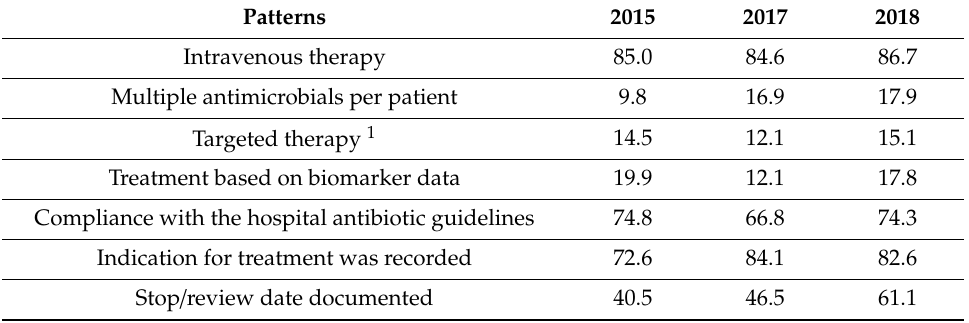
Table 5. Key patterns and quality indicators of systemic antimicrobial drug (AMD) prescribing, %.